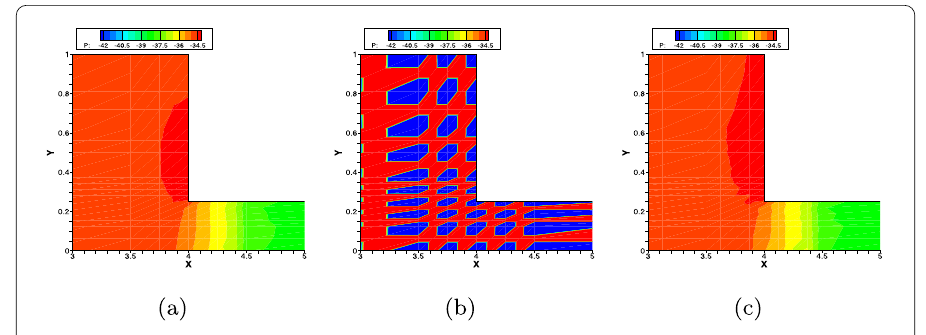
Figure 5 The pressure contours for pressure field p . ( a ) Standard FE p 1 b – p 1 – p 1 dg triples; ( b ) FE p 1 – p 1 – p 1 dg triples without stabilization term; ( c ) FE p 1 – p 1 – p 1 dg triples with stabilization